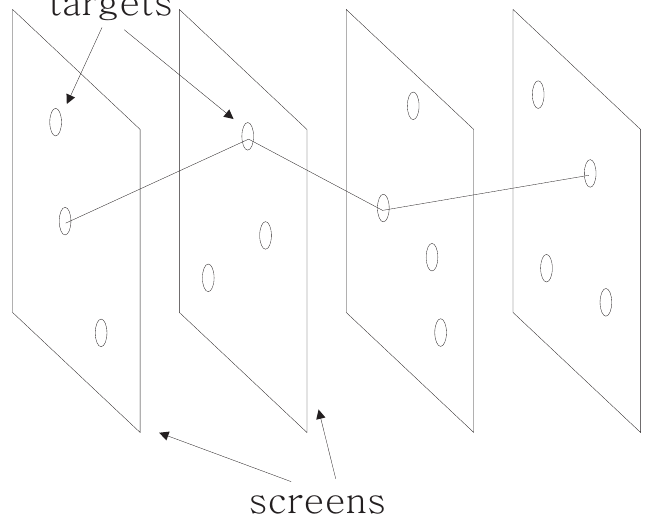
Figure 3. Fixations with targets. The figure shows subsequent scenes/screens with several targets (PFTs) on each. Horizontal axis represents time. The path visualizes one possible